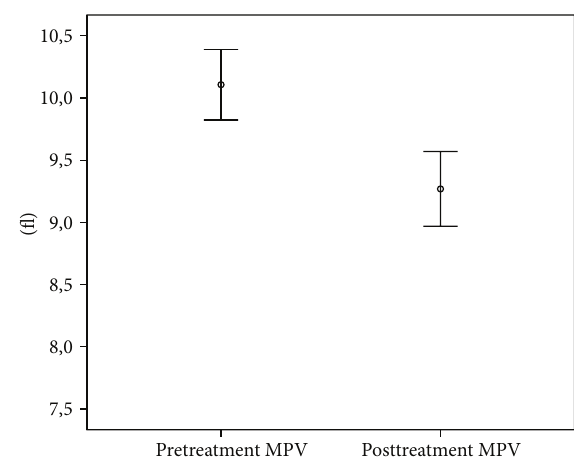
Figure 1: PLT counts prior to and following the treatment.